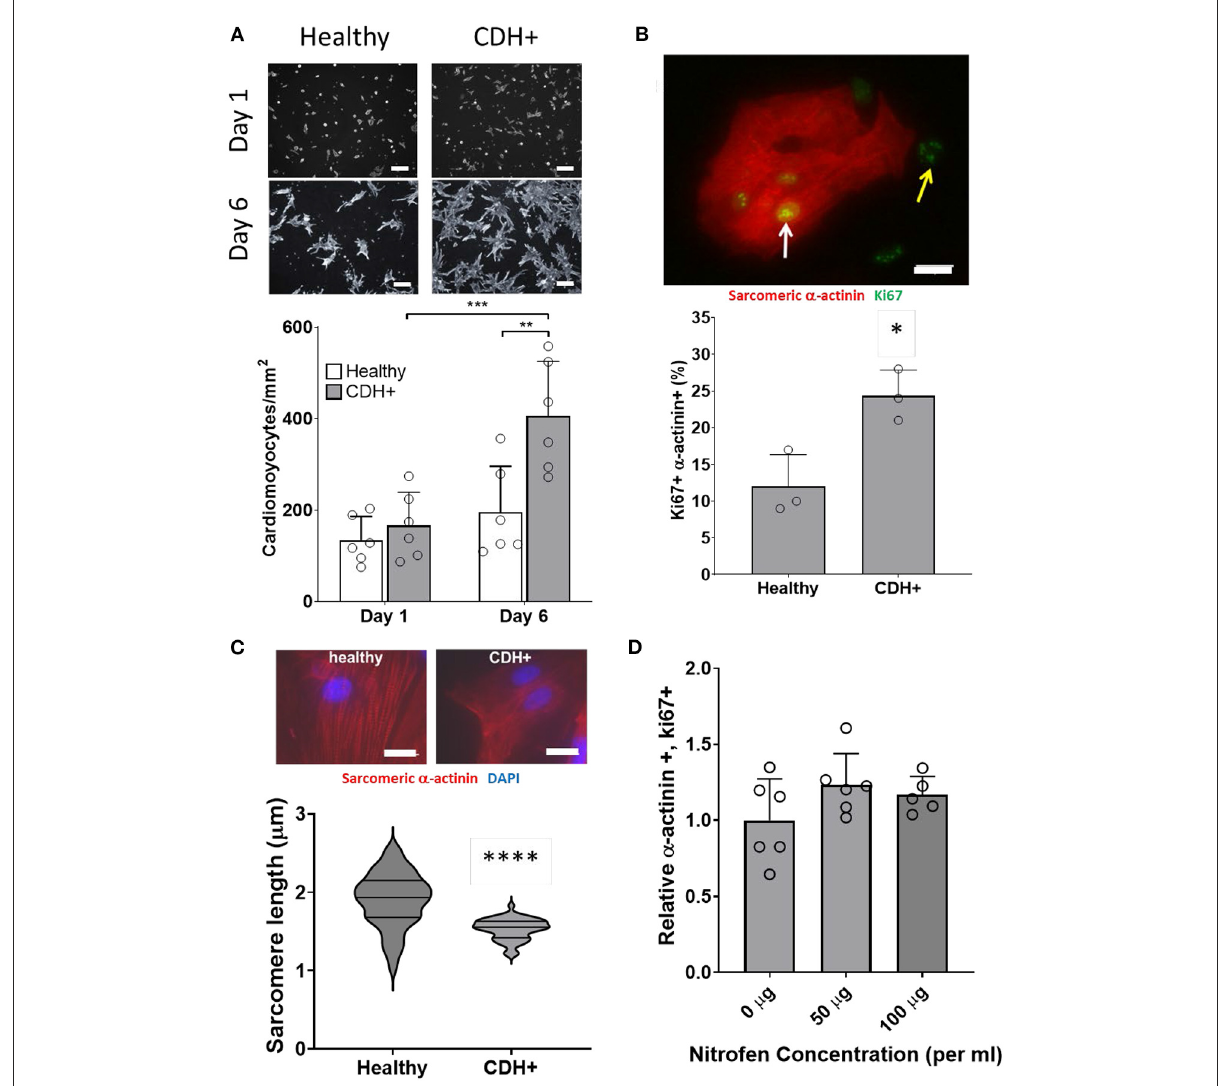
FIGURE4 Characterization of CDH + cardiomyocytes in culture. (A) Representative images of cardiomyocytes ( α -actinin stain in gray scale) after 1 day or 6 days in culture (top). Cardiomyocyte density at 1 and 6 days (bottom). Graph shows mean ± SD ( n = 6). ** Denotes p < 0.01w.r.t. Healthy cells at Day 6. *** Denotes p < 0.001w.r.t. CDH + at 24h. (B) Cardiomyocyte proliferation (Ki67 + α -actinin + ) at 2 days. Inset shows example of Ki67 + cardiomyocyte (white arrow) and non-myocyte (yellow arrow). Graph shows mean ± SD ( n = 3). * Denotes p < 0.05. (C) Representative